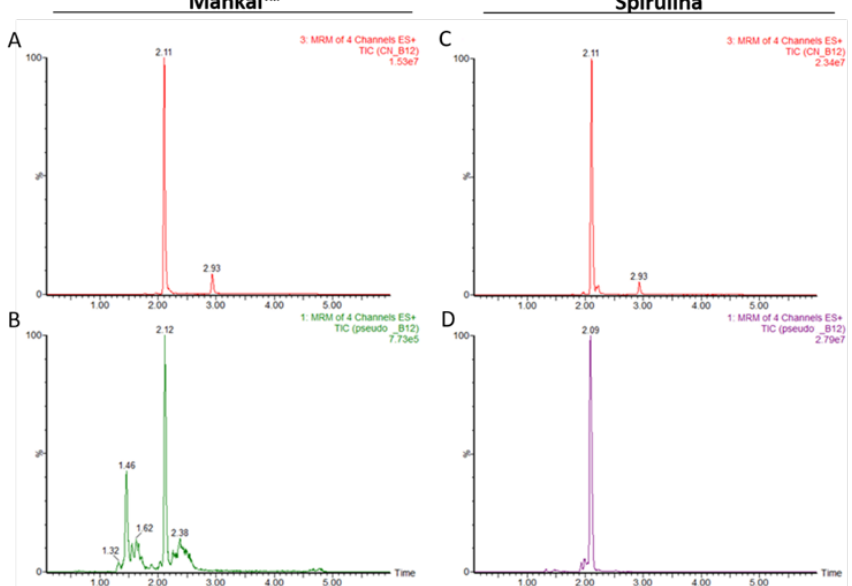
Figure 3. A comparison of chromatograms of TIC for authentic CN-B 12 and pseudo CN-B 12 in Mankai and spirulina samples. ( A – C ): Active CN-B 12 ; ( B – D ) Pseudo CN-B 12 in Mankai™ (A,B) and spirulina (C,D) samples.